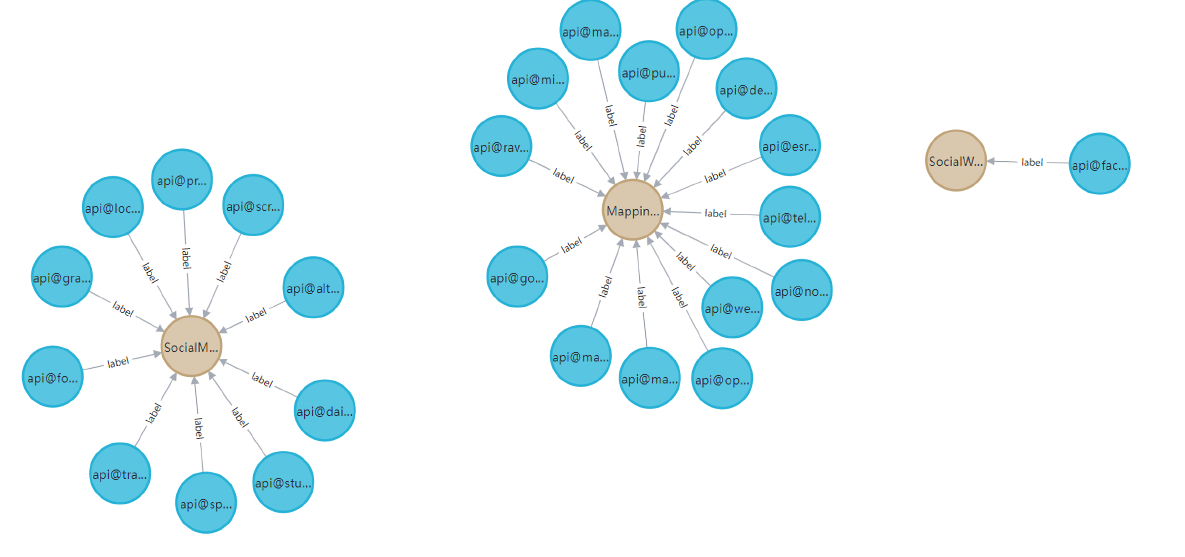
Figure 3. Service knowledge graph in the SDKG